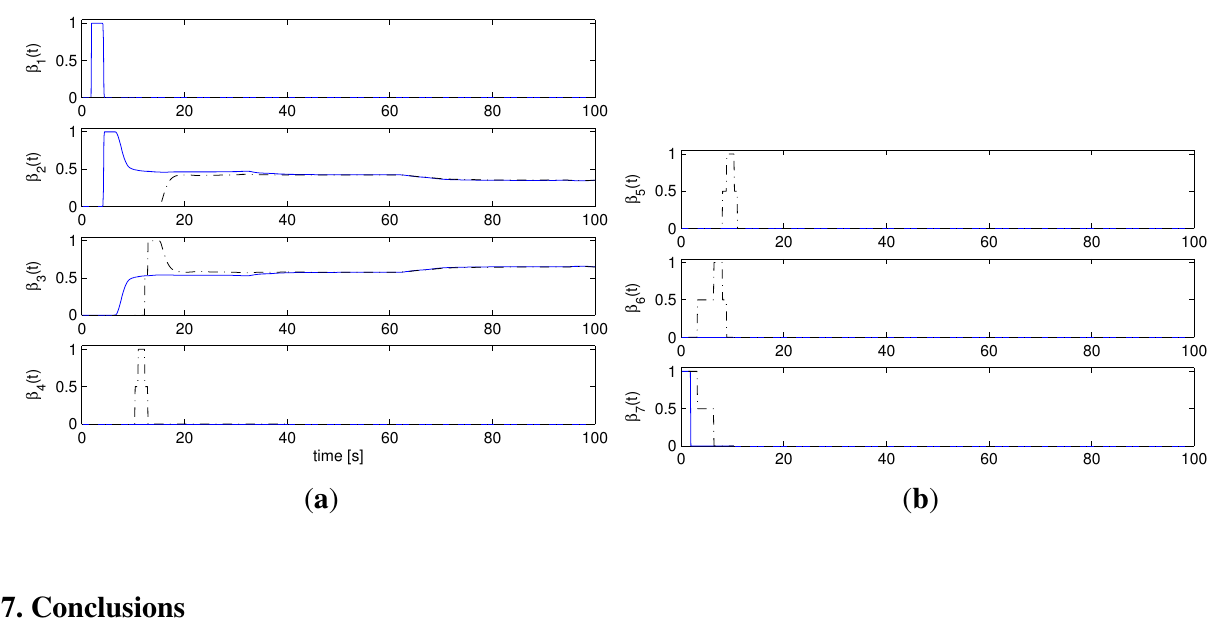
( t ) , β ( t ) , β ( t ) , β ( t ) ; ( b ) β ( t ) , β ( t ) , β ( t ) 1 2 3 4 5 6 7